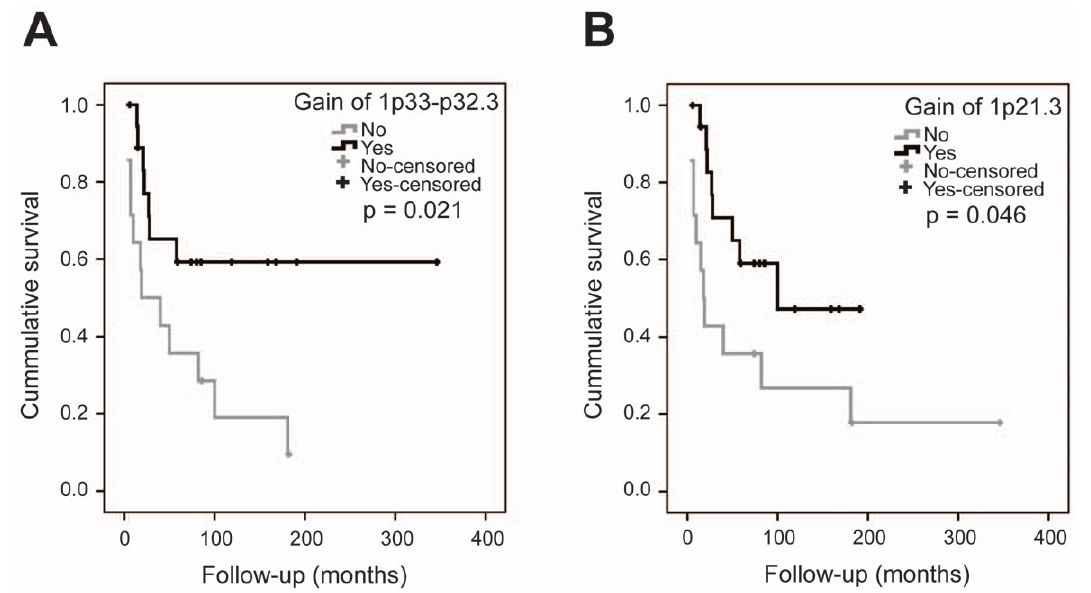
Figure 3. Patient survival curves. Kaplan-Meier plots with overall survival curves for (A) patients with gain of 1p33-p32.3 (n=19) and patients with normal copy number or loss (n=14) and (B) patients with gain of 1p21.3 (n=19) and patients with normal copy number or loss (n=14).